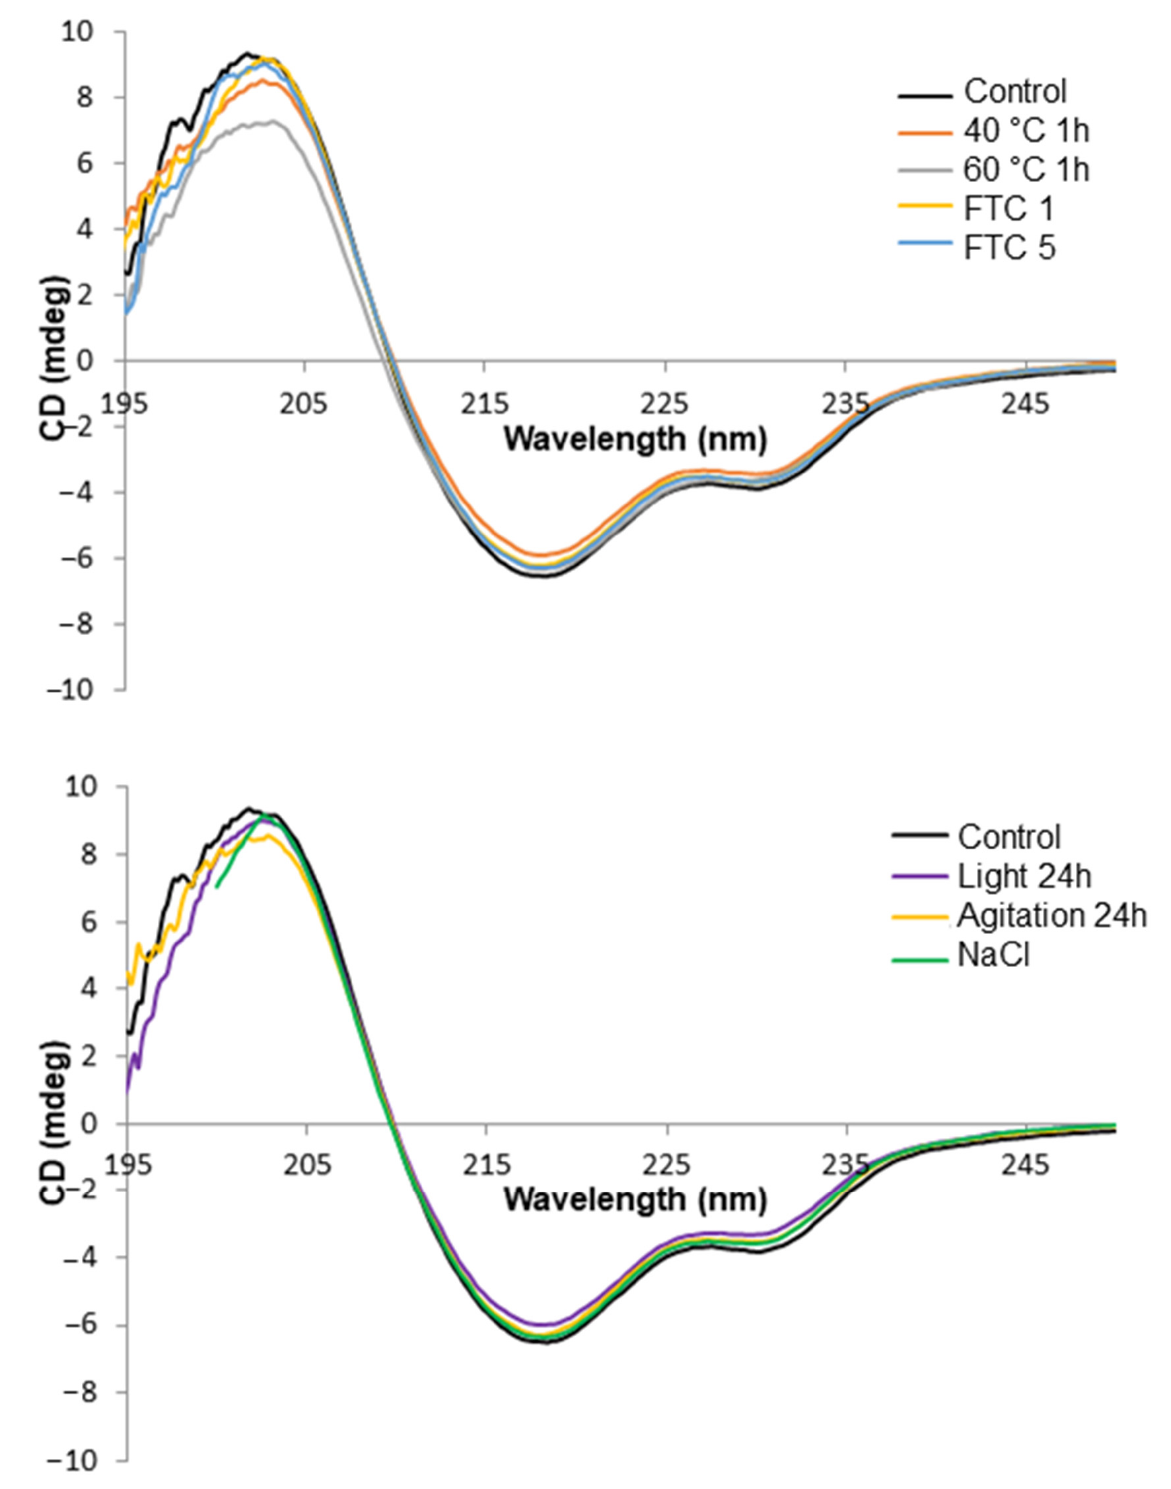
Figure 1. Far-UV CD spectra of all the stressed samples of nivolumab as compared with a control sample (black line).